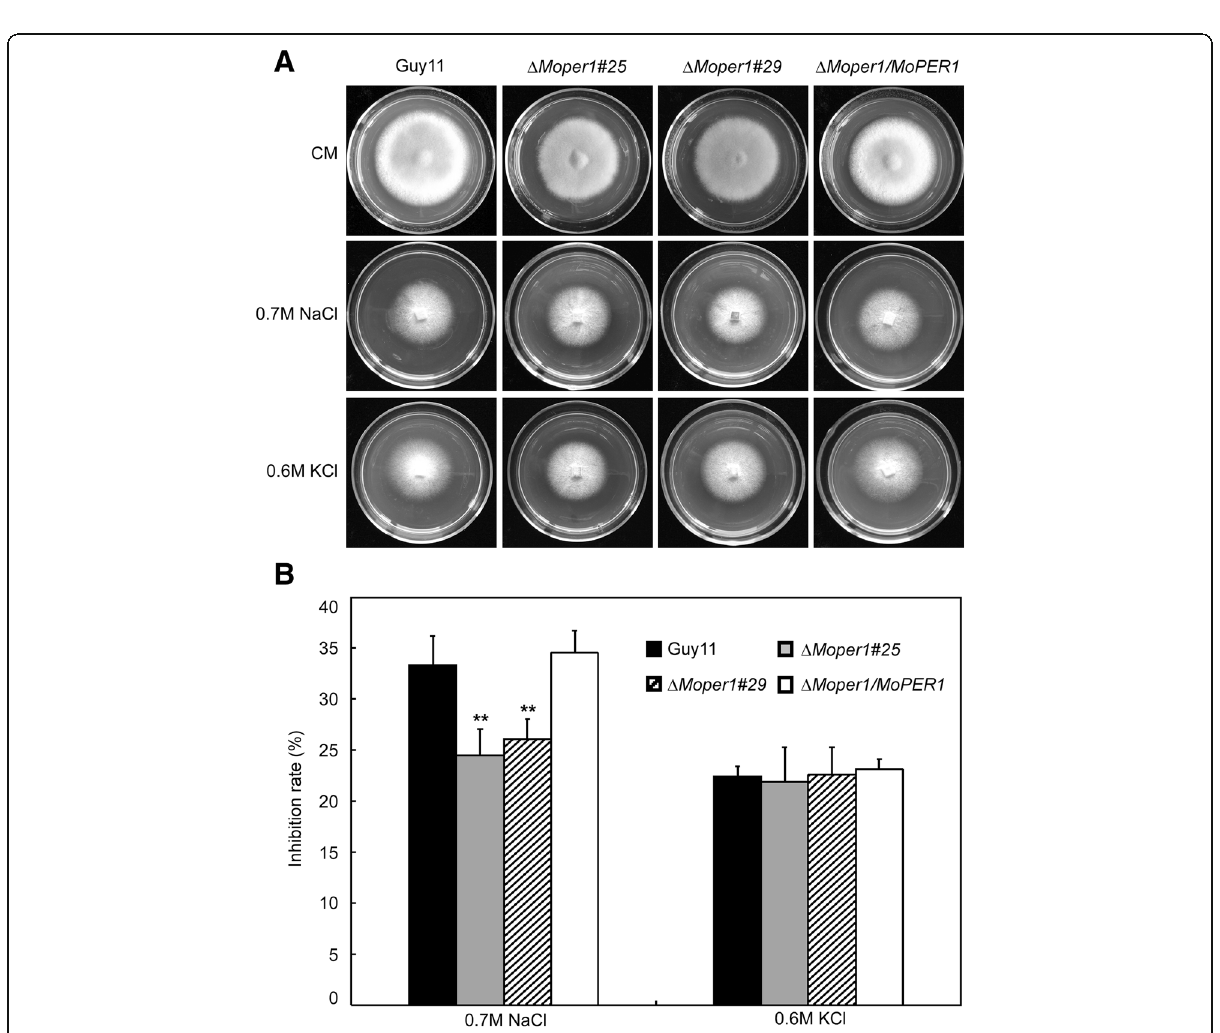
Fig. 2 Δ Moper1 mutants iron stress assessment. a The Δ Moper1 mutants are less sensitive to iron stress than Guy11. Colonies of the wild-type Guy11, the Δ Moper1 mutants and the complemented strains were grown on CM plates with 0.7 M NaCl or 0.6 M KCl and cultured at 28 °C for 7 days. b The growth inhibition rate is estimated relative to the growth rate of each untreated control [Inhibition rate = (the diameter of untreated strain – the diameter of treated strain) / (the diameter of untreated strain × 100%)]. Three repeats were performed and similar results obtained. Error bars represent the standard deviations and lowercase respresent significant differences ( p <